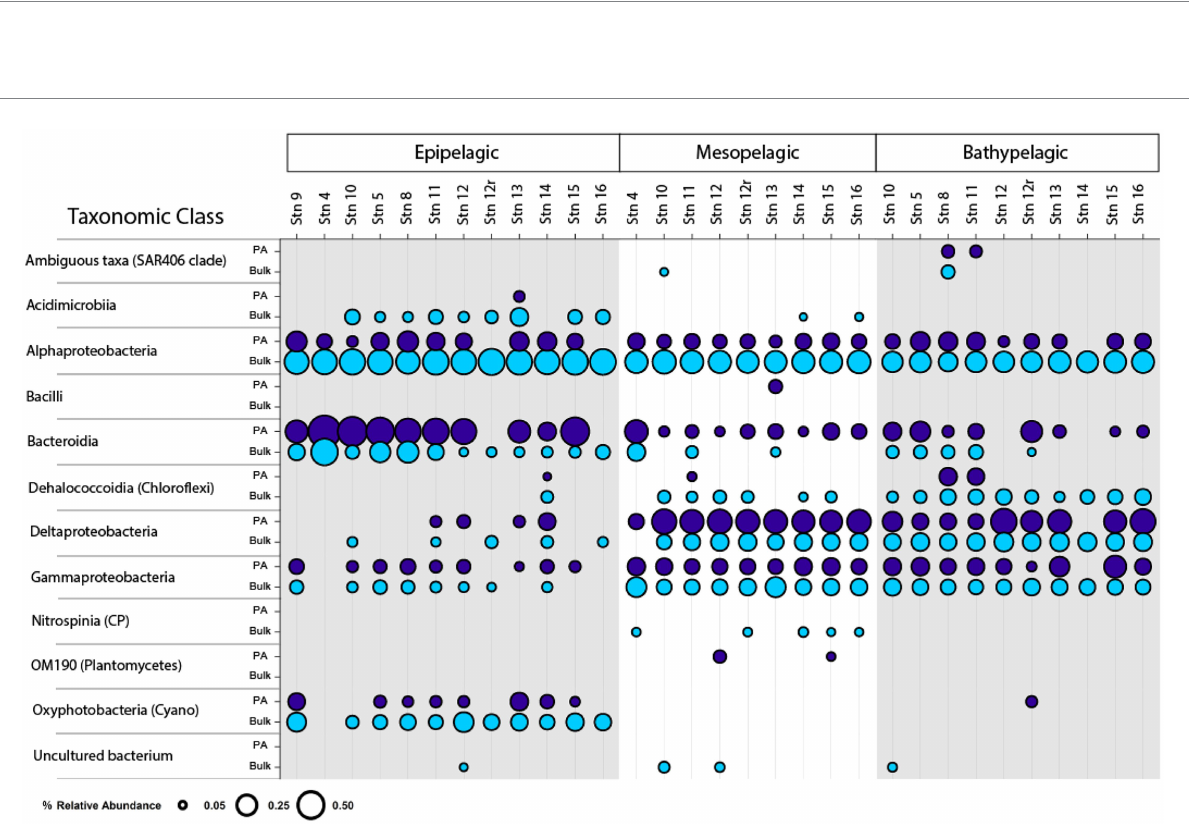
FIGURE 5 Class-level composition of bulk (unfiltered) and PA bacterial communities. Circle size correlates with relative abundance. Data shown were filtered and represents classes with ≥ 5% relative abundance in the data